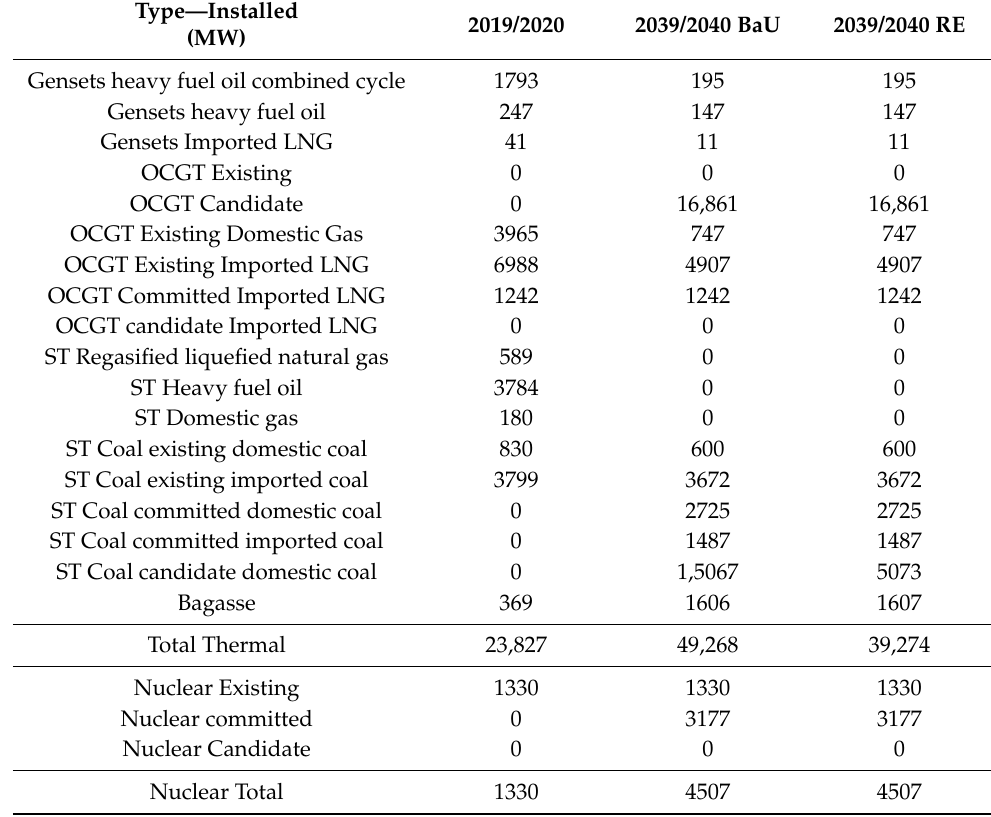
Table 5. List of thermal and nuclear capacities in